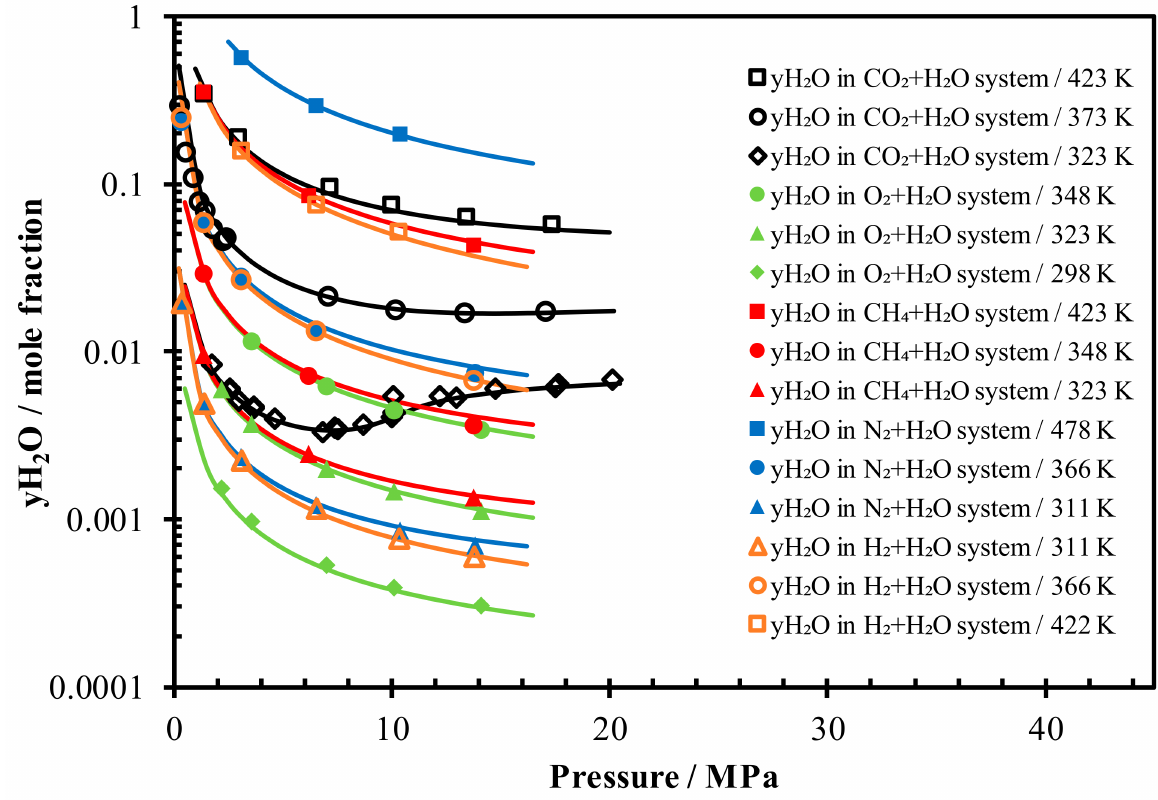
Figure 3. Water content in gas (CO 2 , CH 4 , N 2 , O 2 and H 2 )-rich phase: Comparison of SW EoS predictions (solid lines) with experimental literature data (symbols)